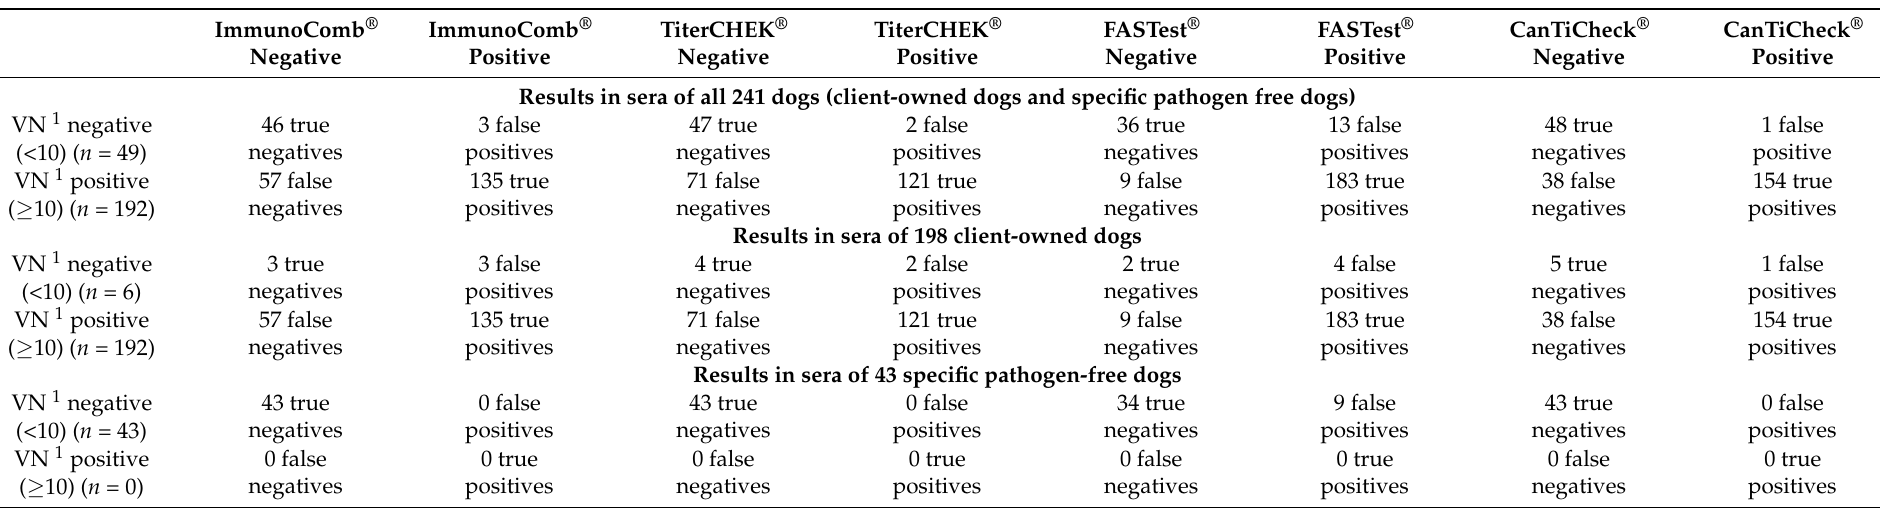
Table 3. Results of anti-canine parvovirus antibody testing in the sera of overall 241 dogs, in the subgroup of 198 client-owned dogs, and in the subgroup of 43 specific pathogen-free dogs, and comparison of the four point-of-care tests, using VN as the reference